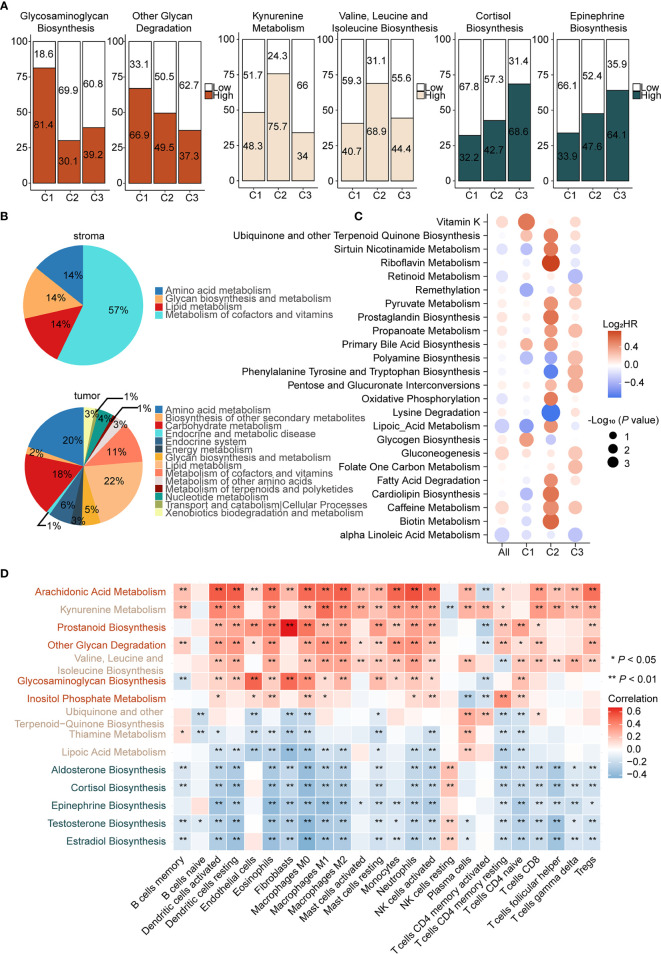
Different pattern of metabolism reprogramming among subtypes and its relationship with immune infiltration (A) Enrichment scores of metabolic pathways were calculated by ssGSEA and then the differential analysis was performed among three subtypes. Significantly upregulated metabolic pathways were selected based on Log2 (fold change). Patients were classed according to the median enrichment scores of featured metabolic pathways of each subtype, and the percentages of the high and the low score group were calculated (left: C1, middle: C2, right: C3). (B) Enrichment scores of metabolic pathways of stroma and tumor samples in GSE115635 were calculated and then the differential analysis was performed (FDR < 0.05 and Log2 (fold change) > 0 was consider significant). Significantly upregulated metabolic pathways were classified into metabolic patterns defined by KEGG. The upregulated metabolic pathways belonging to each category, divided by the total upregulated metabolic pathways, are the percentages of the metabolic pattern in pie charts. (C) Prognostic value of metabolic pathways estimated by the univariate Cox proportional hazards model for OS in TCGA cohort and each subtype. The color represents the hazard ratio, the size of circles represents -Log10 (P value). (D) Spearman correlation matrix of characteristic metabolic pathways and enrichment scores of immune cells in the whole cohort. Correlation coefficients are represented in the form of heatmap using colored scale ranging from blue (minimum correlation) to red (maximum correlation). (*P < 0.05; **P < 0.01).